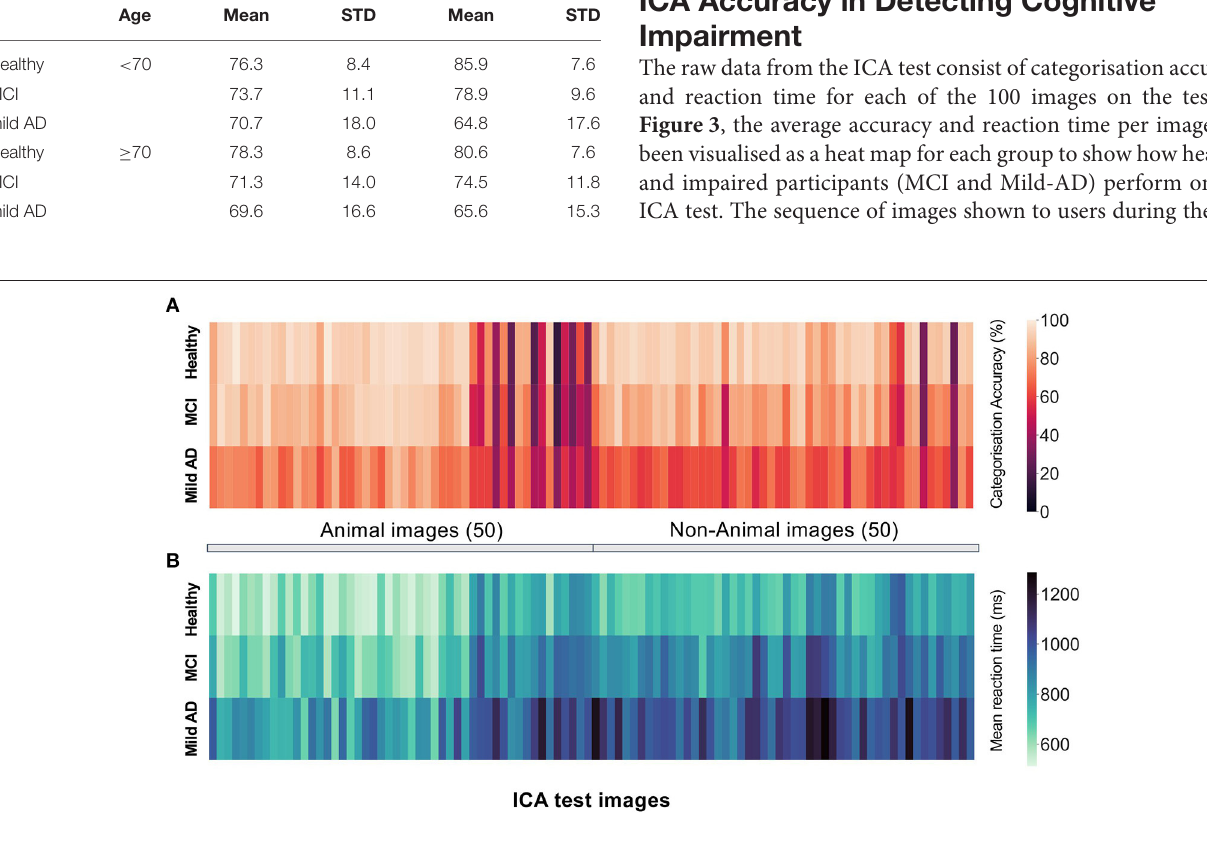
FIGURE 3 | The mean (A) categorisation accuracy (B) reaction time for participants of each diagnosis group for each image on the ICA test. The first 50 blocks represent performance on the animal images, and the second 50 blocks represent performance on the non-animal images. In the actual ICA test the order of the images is